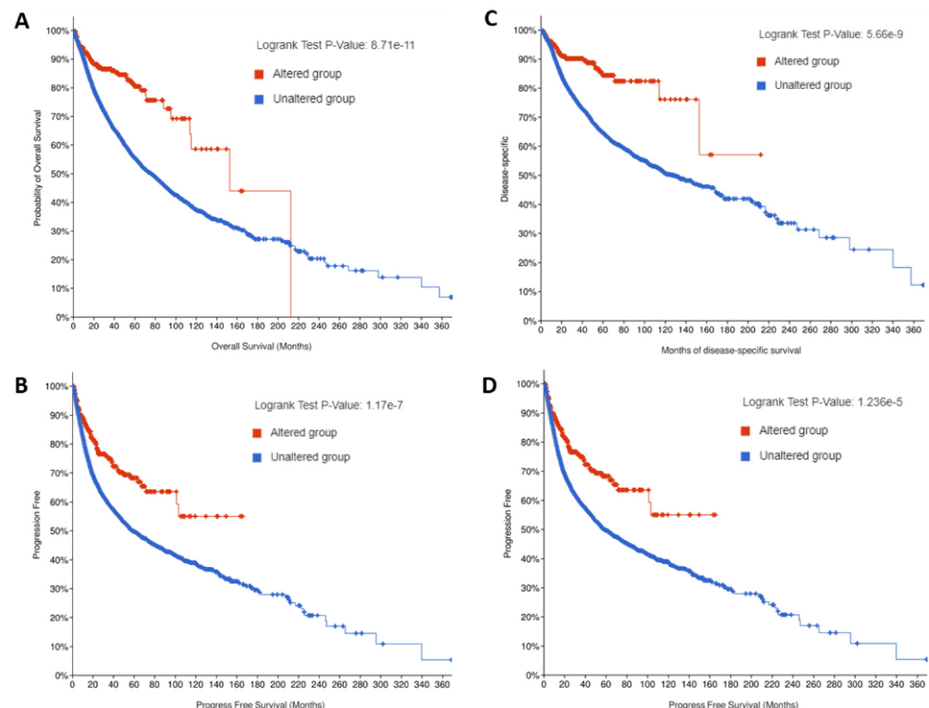
Figure 4. Prognostics for TMPRSS2 mutation in pan-cancers. Data for overall ( A ), progression-free ( B ), disease-specific ( C ), and disease-free ( D ) survival in the mutated group (red line) and WT group (blue line). Unaltered group: wild-type (WT) group. Table 1. Survival of cancer patients with TMPRSS2 mutations.